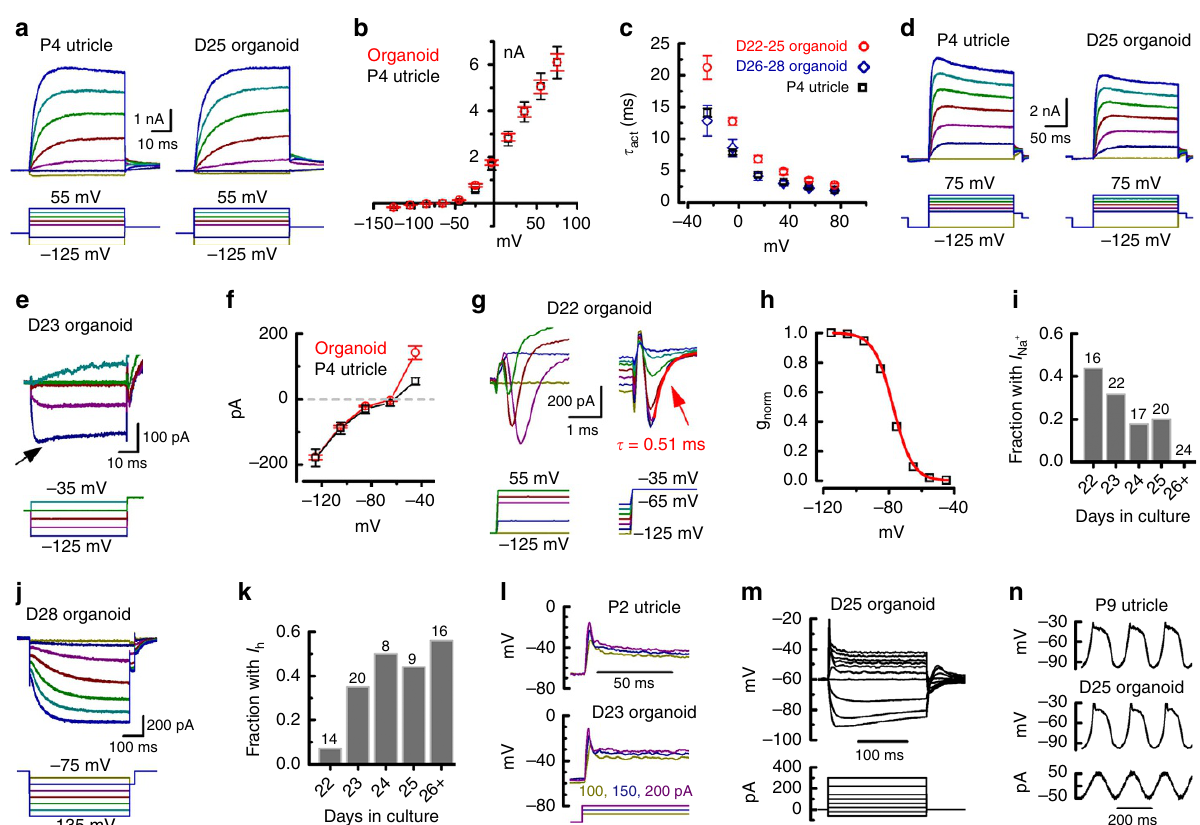
Figure 4 | Electrophysiological properties of organoid hair cells. ( a ) Families of outward K þ currents evoked by the voltage protocol shown below. ( b ) Mean ± s.e.m. peak current–voltage relations for 27 organoid hair cells (D22–28) and eight Type II utricle hair cells (P4). ( c ) Mean ± s.e.m. time constants of single exponential fits to K þ current activation as function of membrane potential for D22–25 ( n ¼ 12), D26–28 ( n ¼ 6) organoid hair cells and P4 utricle hair cells ( n ¼ 7). ( d ) Families of K þ current evoked by a voltage protocol (below) with a prepulse to (cid:2) 125mV. ( e ) A family of fast inward rectifier currents recorded from a D23 organoid hair cell evoked by the protocol shown below. ( f ) Mean ± s.e.m. peak inward rectifier current–voltage relations for 27 organoid hair cells and eight utricle hair cells. ( g ) Families of Na þ current activation (left) and inactivation (right). ( h ) The voltage dependence of Na þ current inactivation extracted from the peak inward currents (panel g , right) plotted as a function of prepulse potential and fit by a Boltzmann curve with V 1/2inact ¼ (cid:2) 78.3mV and s ¼ 5.9mV. ( i ) Prevalence of Na þ current in organoid hair cells as a function of days in culture. Total number of cells for each age is indicated above the bars. ( j ) A family of slow hyperpolarization-activated currents ( I h ) evoked by the protocol below. ( k ) Prevalence of I h in organoid hair cells as function of days in culture. Number of cells is indicated above each bar. ( l ) Representative membrane responses of utricle and organoid hair cells to step current injections (below). ( m ) A family of voltage responses evoked by incremental current steps. ( n ) Representative utricle and organoid hair cell membrane responses to sinusoidal current